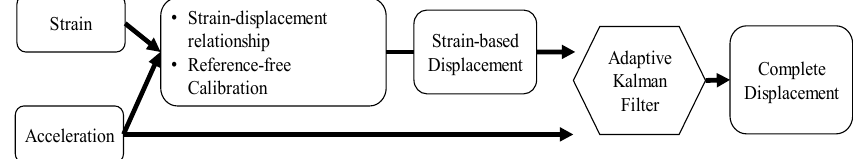
Figure 1. Overview of the proposed method.